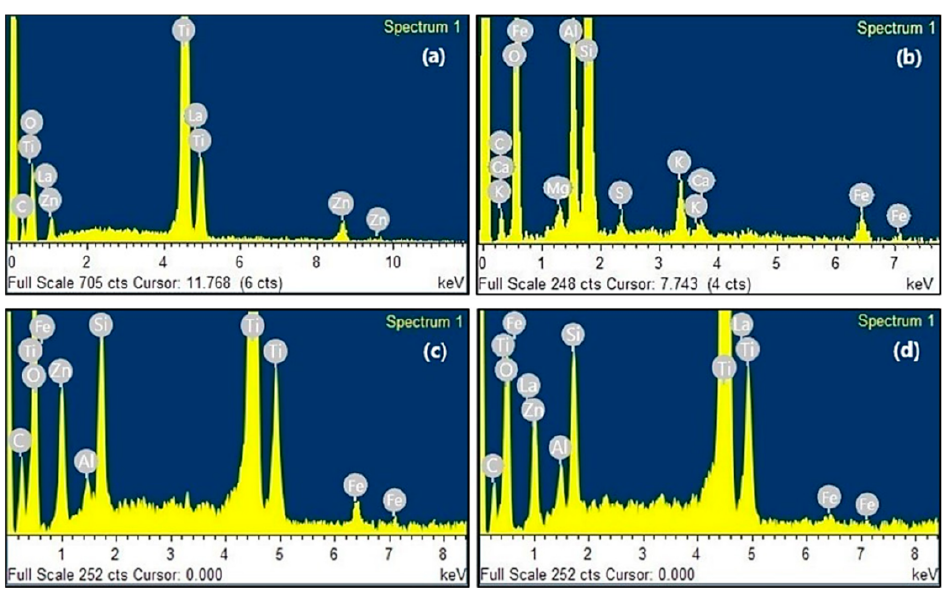
Figure 5. Energy dispersive X-ray (EDX) spectrum of ( a ) ZnTiO 3 /TiO 2 /La (ZTO/La), ( b ) diatoma-